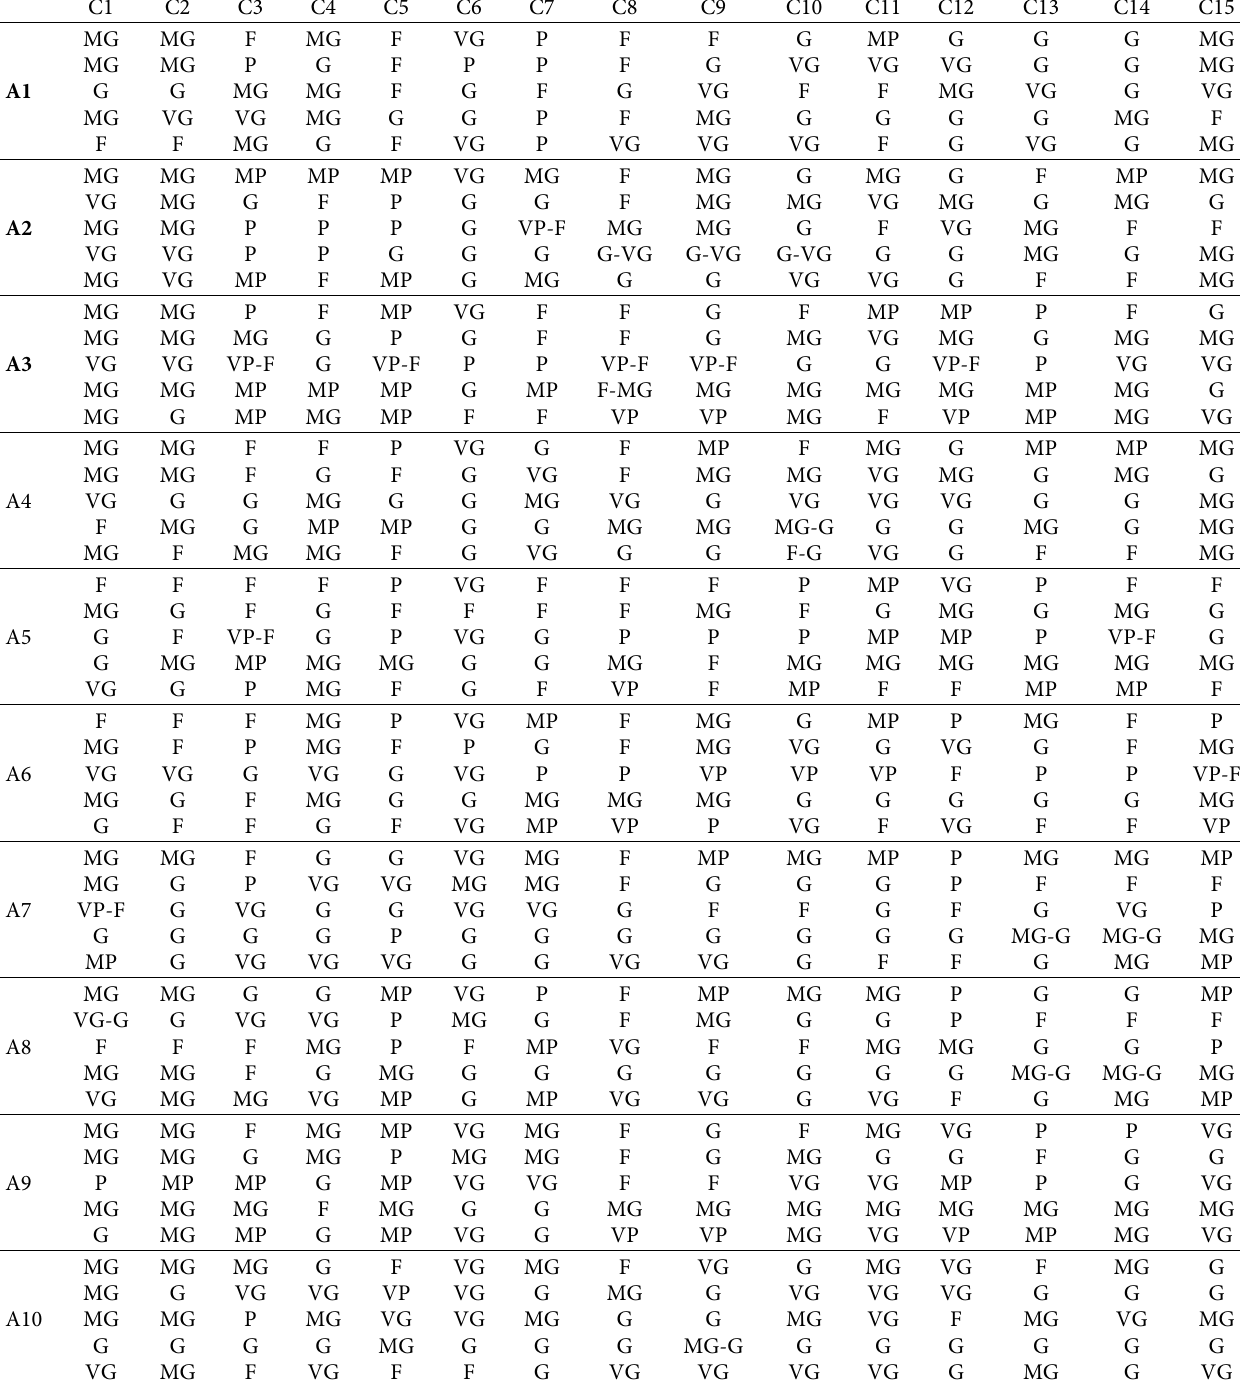
Table 7: 5 DMs’ evaluations of combi boilers with respect to each